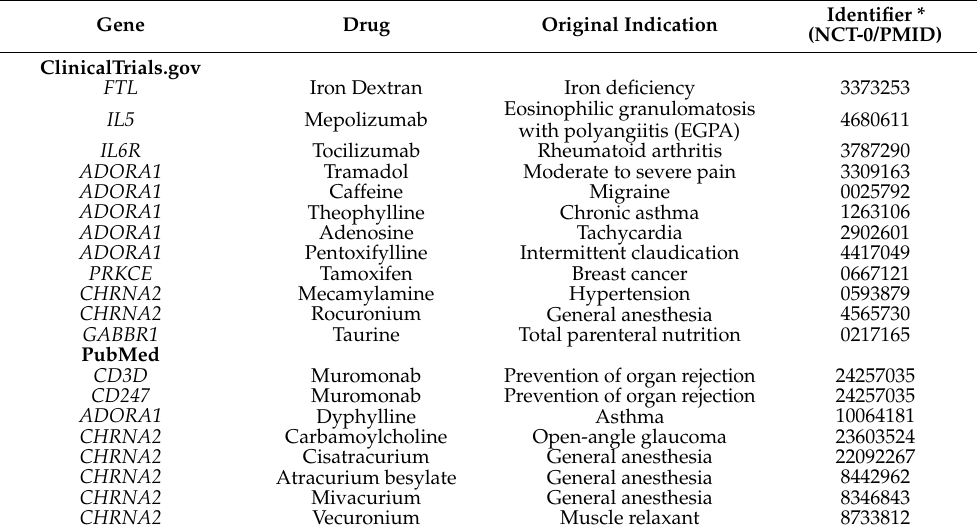
Table 2. Pharmacological therapies in development for the treatment of depression.